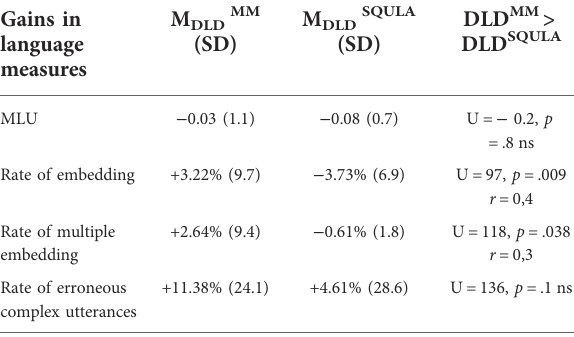
TABLE 6 Gains (between post-training and pre-training scores) in DLD MM and DLD SQULA . Gains